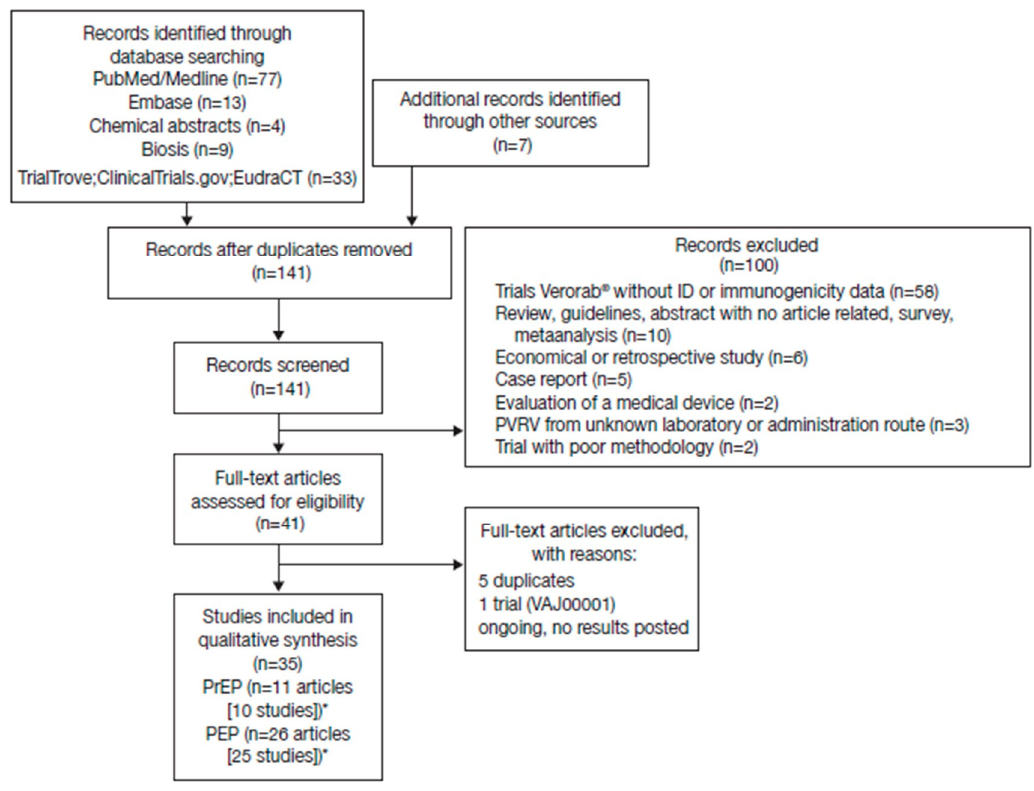
Figure 1. Studies identified through electronic database searches and other sources. *Some studies reported both pre-exposure prophylaxis (PrEP) and post-exposure prophylaxis (PEP) data.